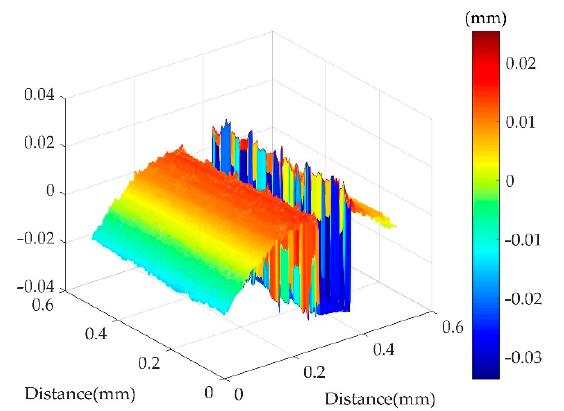
Figure 13. Step surface.